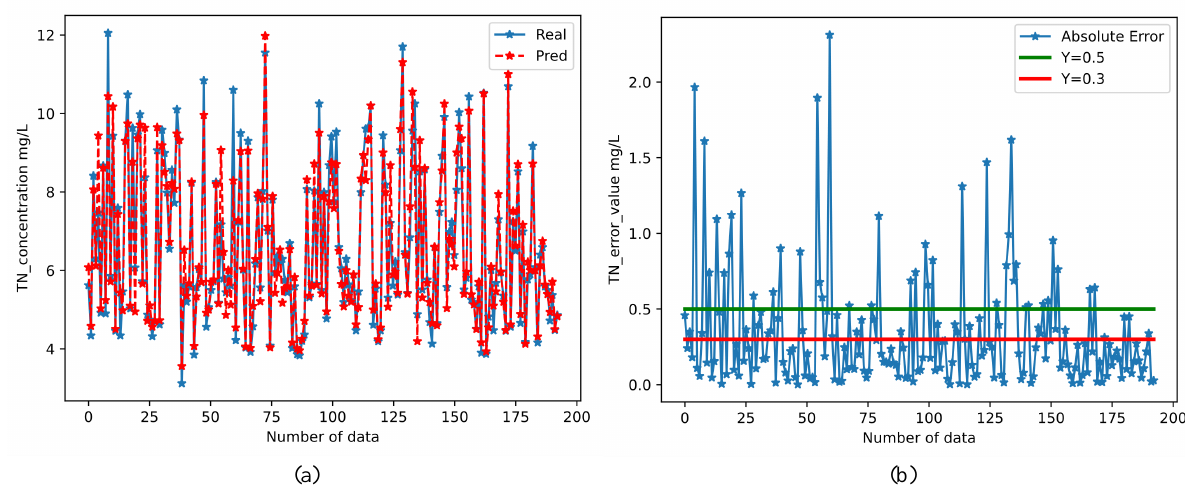
Figure 7. ( a ) Comparison between predicted TN values in random forest and observed TN values ( b ) Absolute errors between the predicted and observed values of